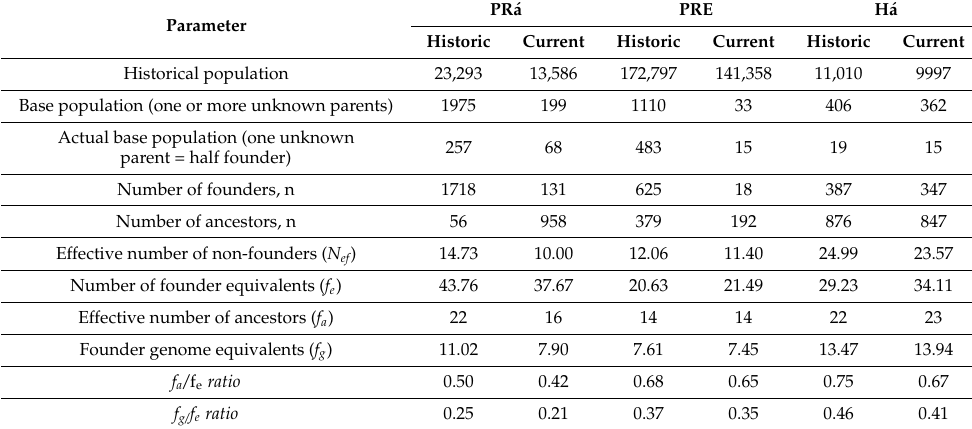
Table 5. Measures of genetic variability and analysis of gene origin, effective number of non-founders ( N ef ), number of founder equivalents ( f e ), effective number of ancestors ( f a ) of Arabian purebred (PR á ), Spanish purebred (PRE) and Hispano-Arabian (H á ) horse